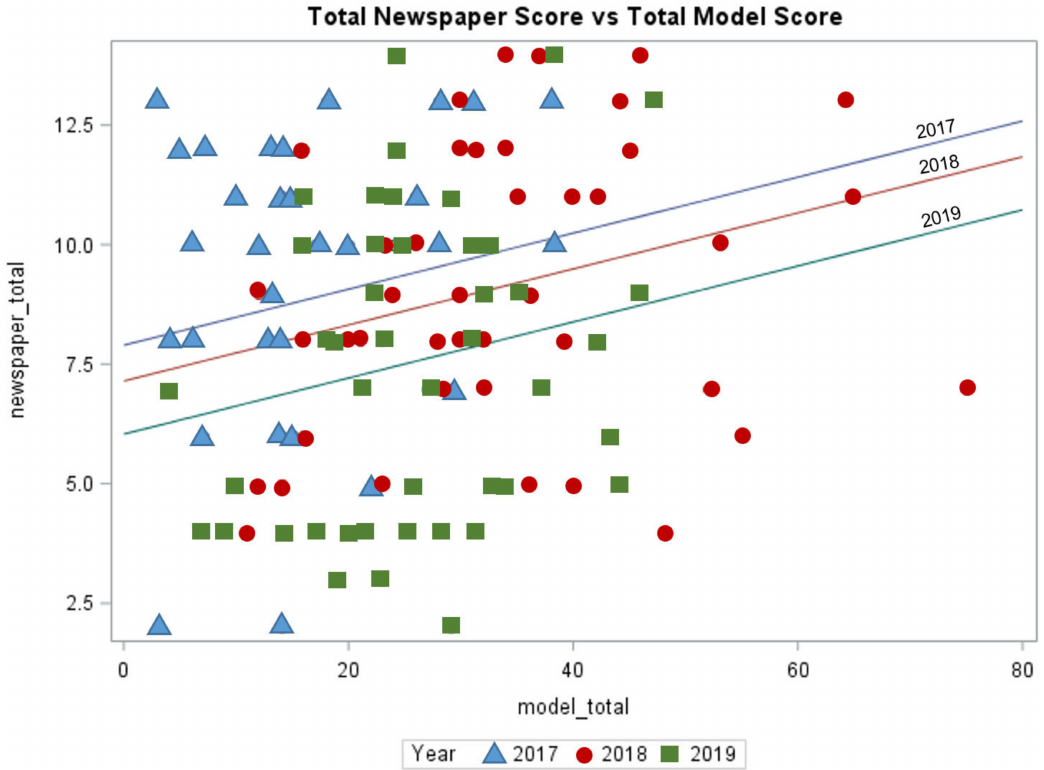
Figure 3. Observed values by year with associated regression